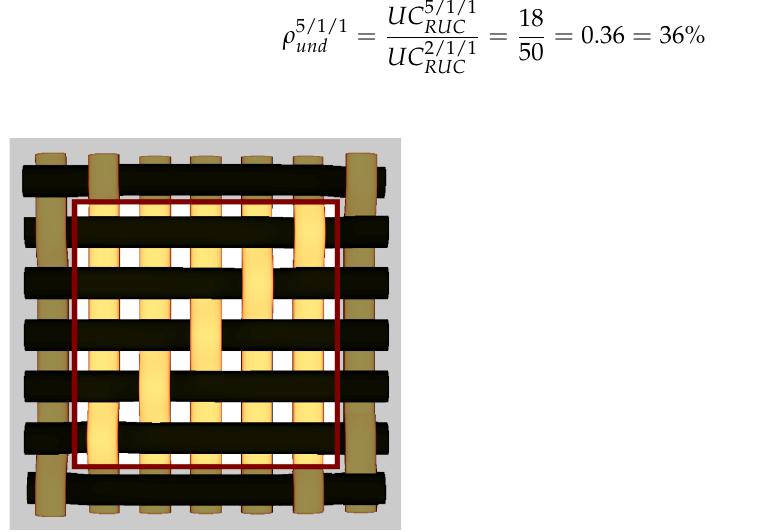
Figure 8. The RUC of satin 5/1/1 relative to a 7 × 7 yarns reference area